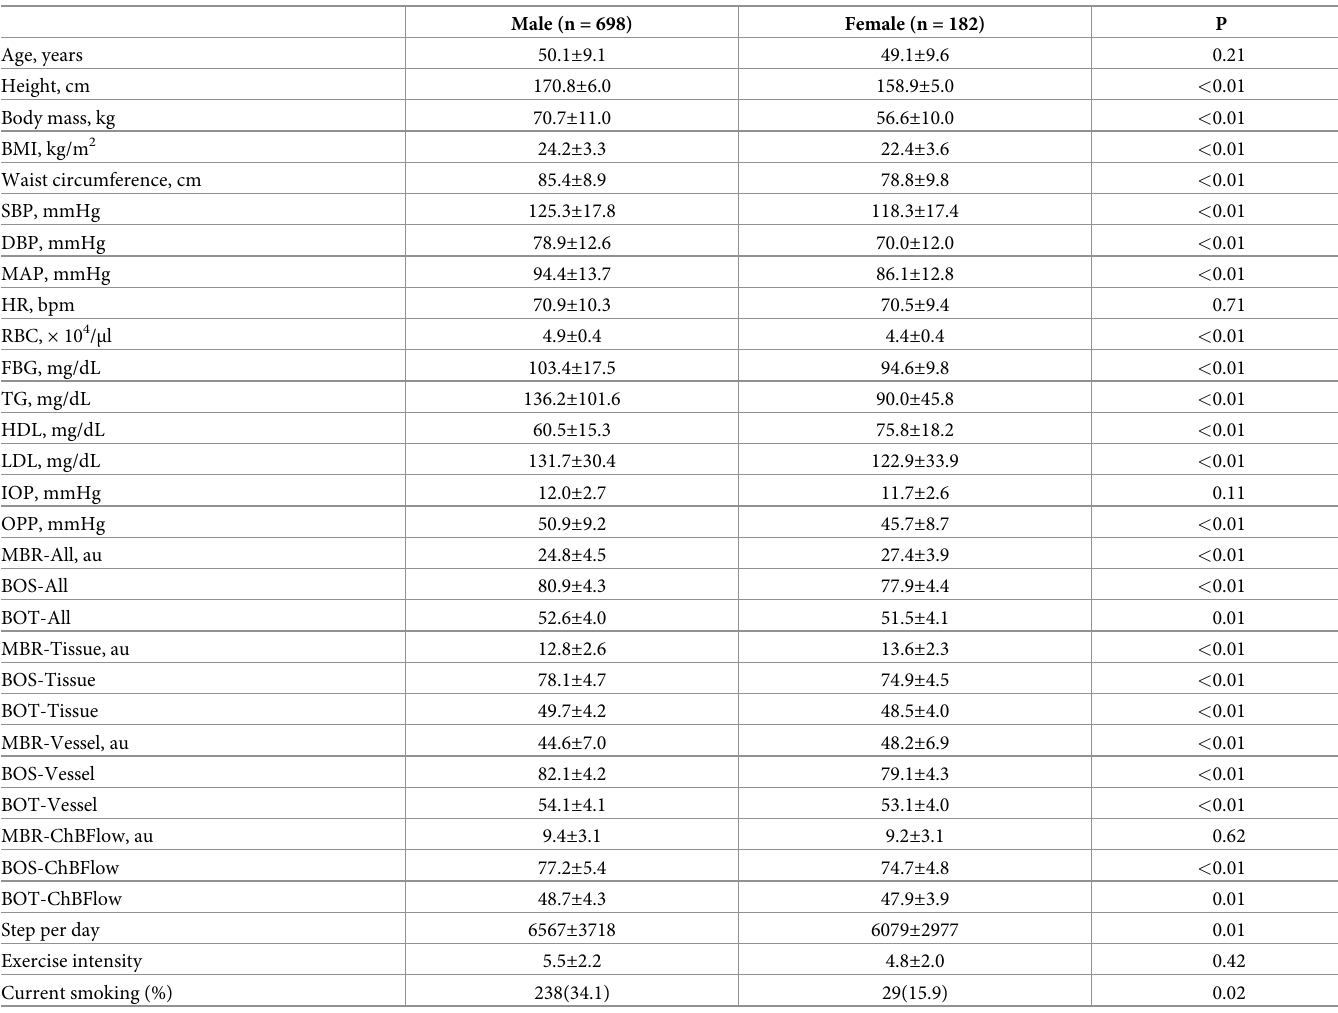
Table 4. The characteristics of male and female